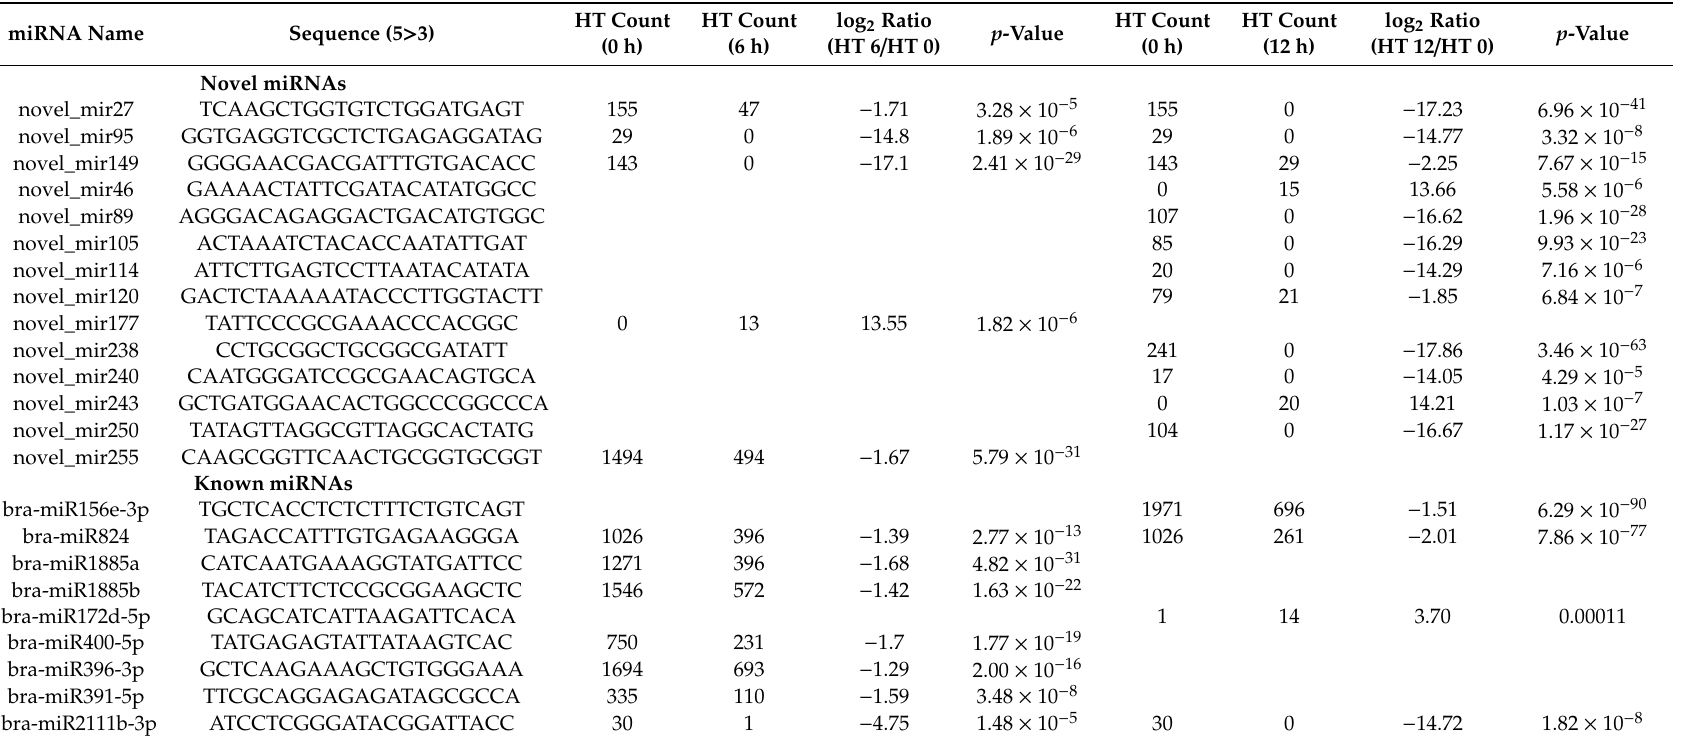
Table 2. Di ff erentially expressed heat responsive novel and known miRNAs identified in heat tolerant (HT) flowering Chinese